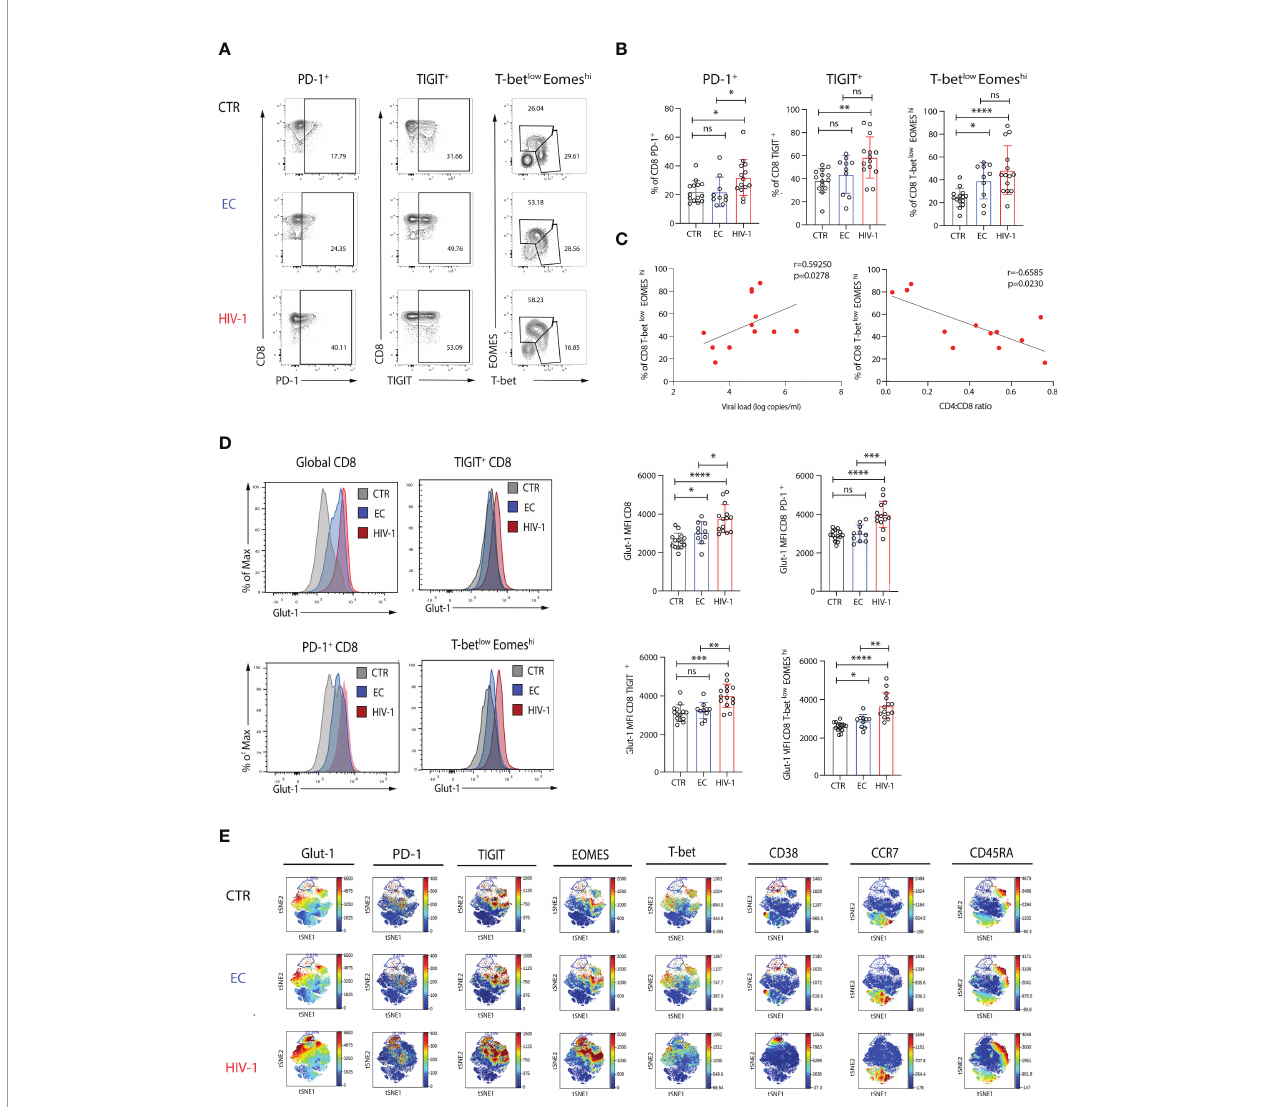
FIGURE 1 | Increased expression of Glut-1 on exhausted CD8 T cells from viraemic HIV-1 infected patients. (A) Representative fl ow plots of percentage of PD-1 + , TIGIT + , and T-bet low EOMES hi. in CD8 T cells from an HIV-1 negative control (CTR), an elite controller (EC), a viraemic HIV-1 positive donor (HIV-1) and (B) summary data from n = 14 HIV-1 negative controls (CTR) n = 10 elite controllers (ECs), n = 14 viraemic HIV-1 positive donors (HIV-1). (C) Correlation between percentage of T-bet low EOMES hi CD8 T cells from n = 14 viraemic HIV-1 positive donors and viral load (log copies/ml) or CD4:CD8 ratio. (D) Representative histograms and summary data of Glut-1 expression on global CD8 T cells, PD-1 +, TIGIT + , and T-bet low EOMES hi CD8 T cells in n = 14 HIV-1 negative controls (CTR) n = 10 elite controllers (ECs), n = 14 viraemic HIV-1 positive donors (HIV-1). (E) ViSNE analysis of multiparametric fl ow data from concatenated fi les was performed on CD8 T cells from the CTR, EC, and HIV-1 positive individuals showing expression of Glut-1, PD-1, TIGIT, EOMES, T-bet, CD38, CCR7, and CD45RA. Each point on the viSNE map represents a single cell and color depicts intensity of protein expression. The non-parametric Spearman test was used for correlation analysis. Signi fi cance determined by Mann-Whitney U test, ns: non-signi fi cant, *p < 0.05, **p < 0.01 , ***p < 0.001, ****p <